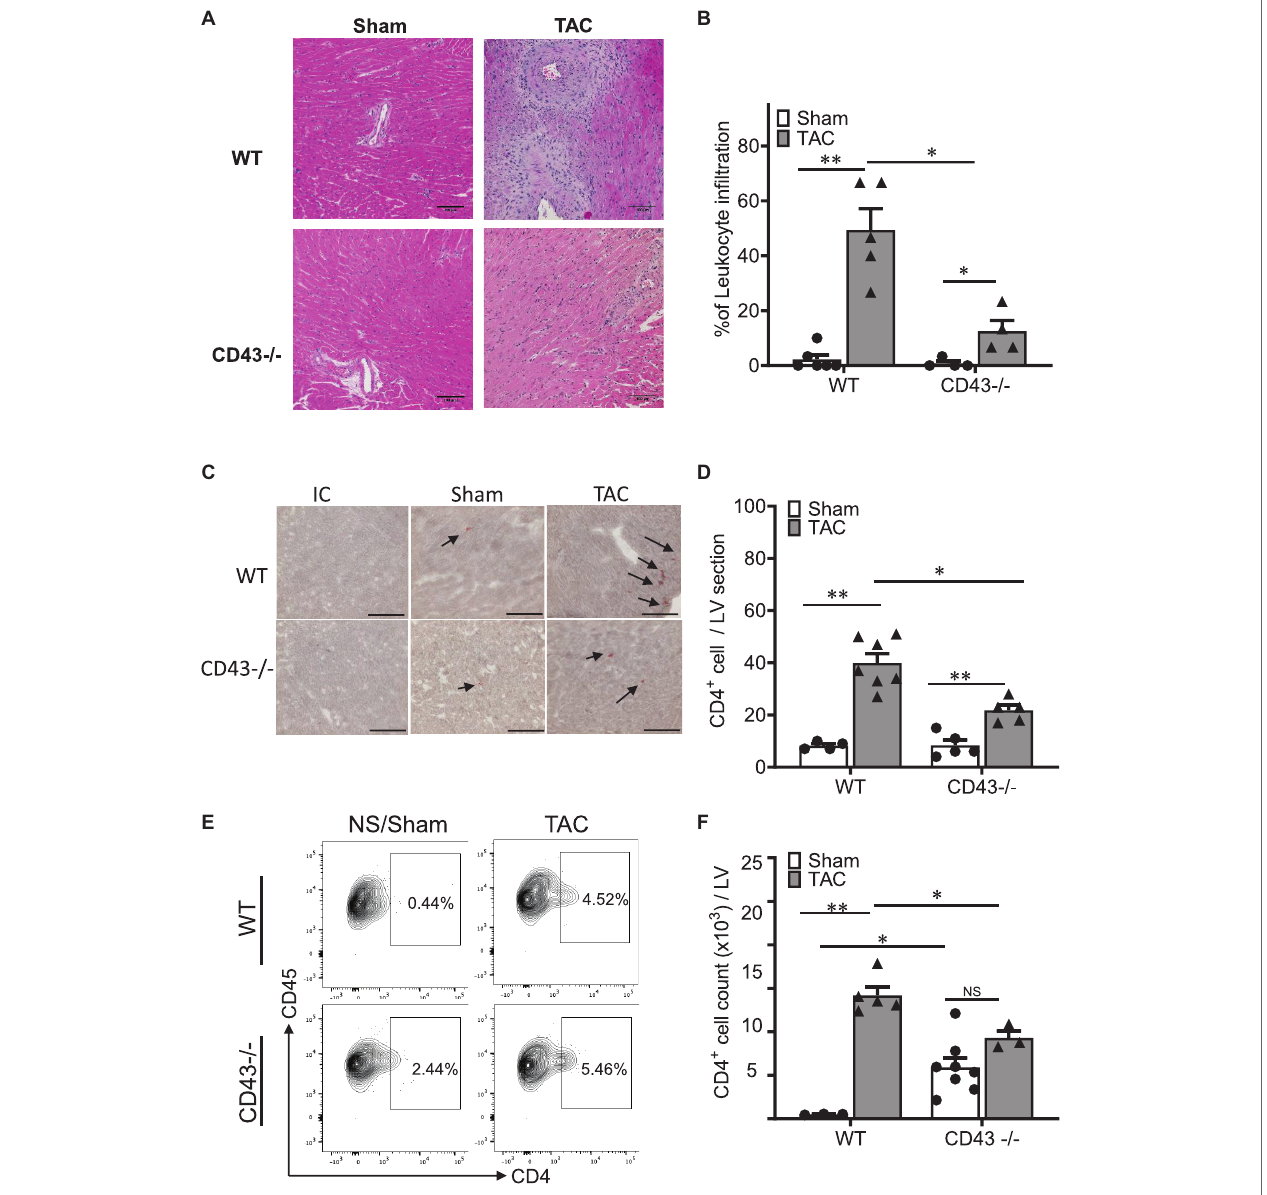
FIGURE 3 | CD43 − / − mice exhibit reduced leukocyte and CD4+ T cell infiltration into the LV in response to TAC. (A) . Representative hematoxylin and eosin (H&E) staining of WT and CD43 − / − heart sections collected 4 weeks after TAC and Sham surgery. (B) Quantification of leukocyte infiltrates in WT and CD43 − / − Sham and TAC LV across the whole heart section. (C) Representative CD4 staining images of WT and CD43 − / − heart sections from TAC and Sham animals. (D) Quantification of CD4+ T cell infiltrates in WT and CD43 − / − Sham and TAC LV across the whole heart section. (E) Representative flow cytometric panels of CD4+ T cell. (F) Quantification of flow cytometric analysis. IC is isotype control; arrows indicate to immune reactivity for CD4 antibody. Scale bars, 100 μ m. * p ≤ 0.05; and ** p ≤